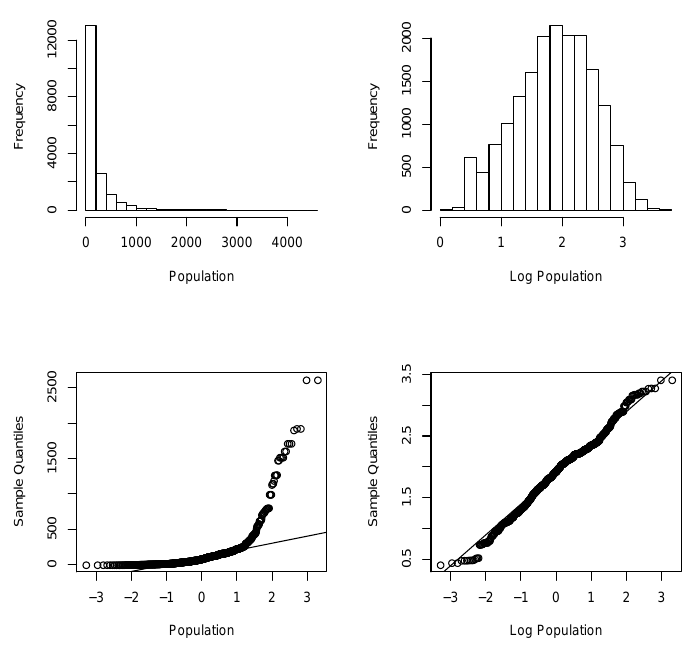
Figure 3. Histograms are shown in the top and Q-Q plots with normality line in the bottom. In the left the original data is presented and in the right the logarithmic form is